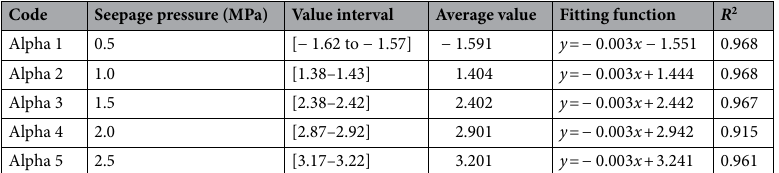
Table 3. Distribution of LG( βK ) values for specimens at a displacement of 5